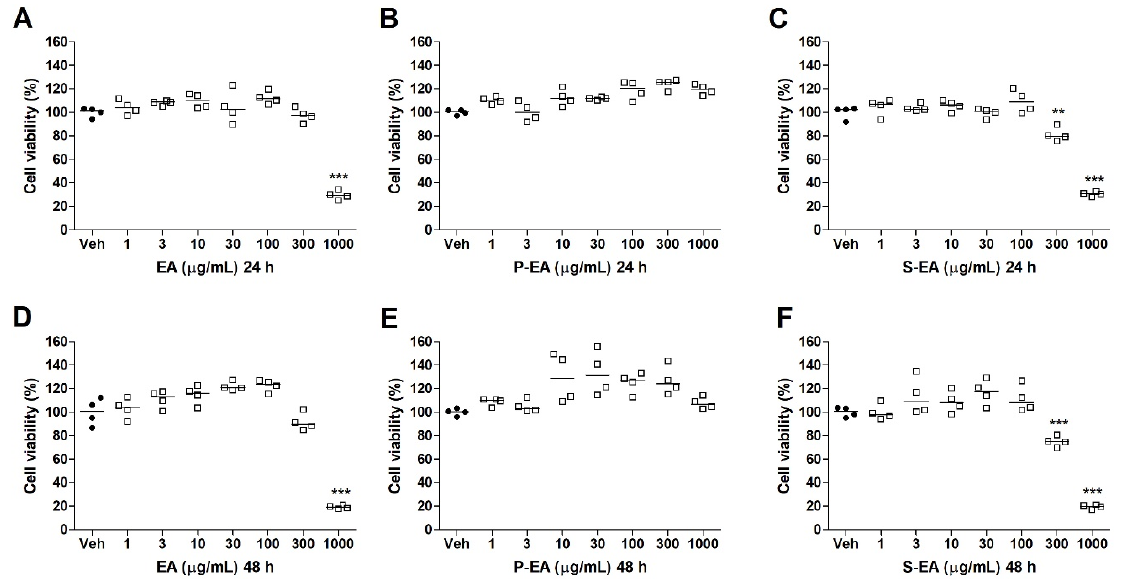
Figure 5. Cell viability of HepG2 cell line treated with EA ( A , D ), P-EA ( B , E ), and S-EA ( C , F ). Cells were incubated with the extracts (1, 3, 10, 30, 100, 300, or 1000 µg/mL) for 24 h and 48 h. Statistical analyses were performed by unpaired t -test. The results represent the median of two independent experiments ( n = 4). ** p < 0.01; *** p < 0.001 compared to vehicle group (control group).